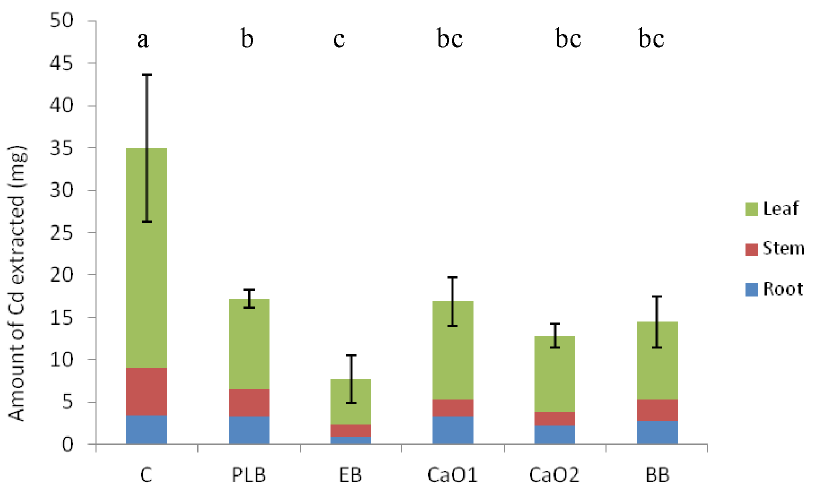
Figure 4. Total amount of Cd extracted by plants. Different letters in the same indicate statistical significant differences for the factor ‘‘type of amendment’’ (P , 0.05).